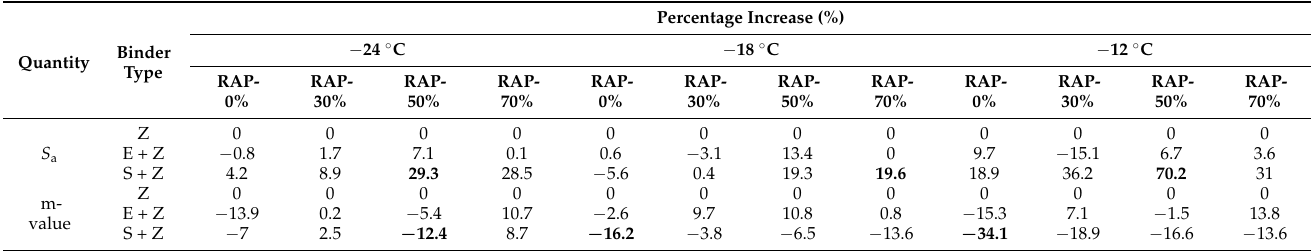
Table 12. Percentage increases of S a and m-value caused by the WMA additive under the long-term aged